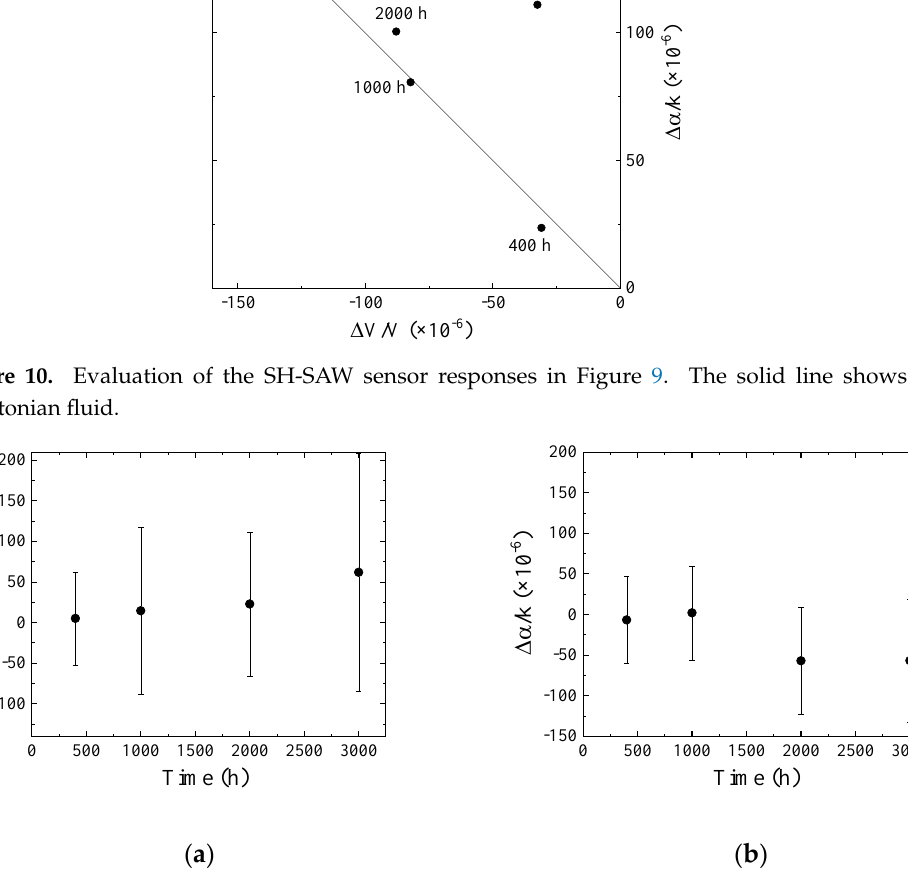
Figure 11. ( a ) Velocity and ( b ) attenuation changes obtained from the differential signal between Ch.1 and Ch.2 as a function of heated and Ch.2 as a function of heated time.